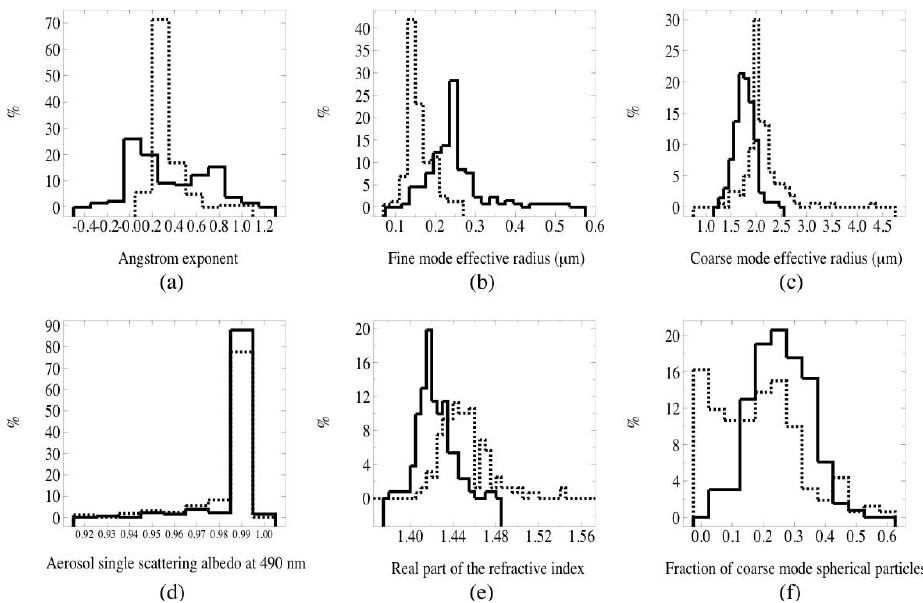
Fig. 3. Histograms of aerosol parameters retrieved for 16 April 2010 (dash lines) and for 7 May 2010 (solid lines). The area selected for 16 April 2010 is shown in Fig. 1a (red box). The area selected for 7 May 2010 is shown in Fig. 2 (black